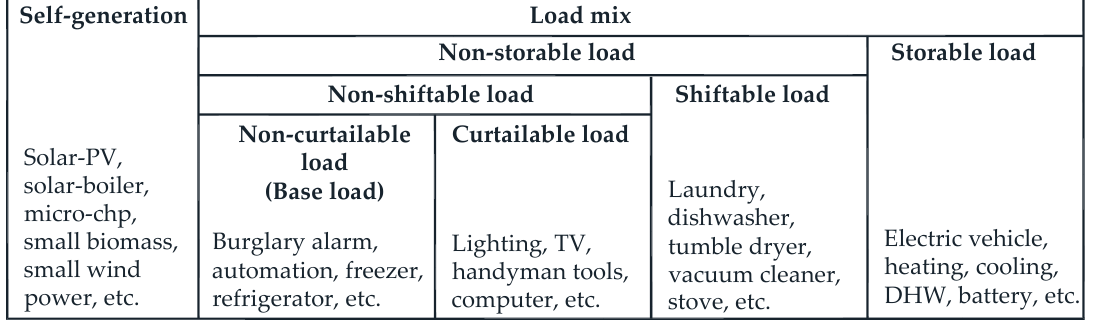
Figure 1. General loads mix and self-generation.